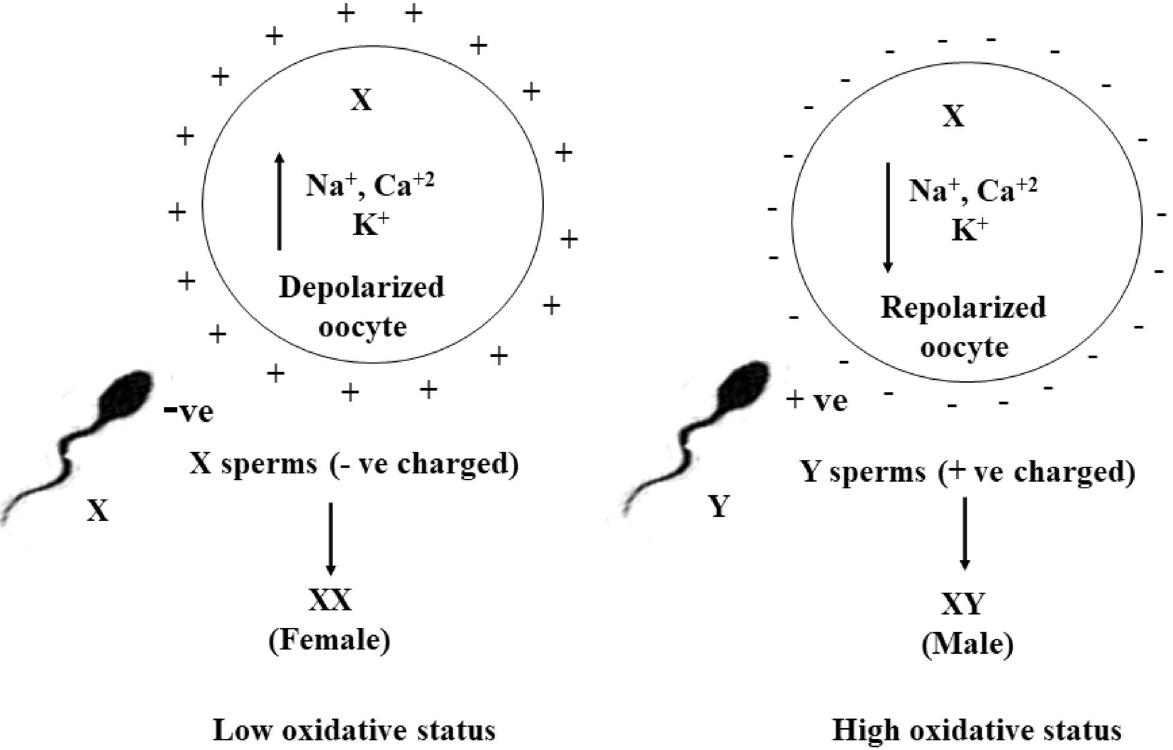
Figure 1. Oxidative status mediated change in polarity of oocytes for sex-specific sperm fertilization to produce selected sex